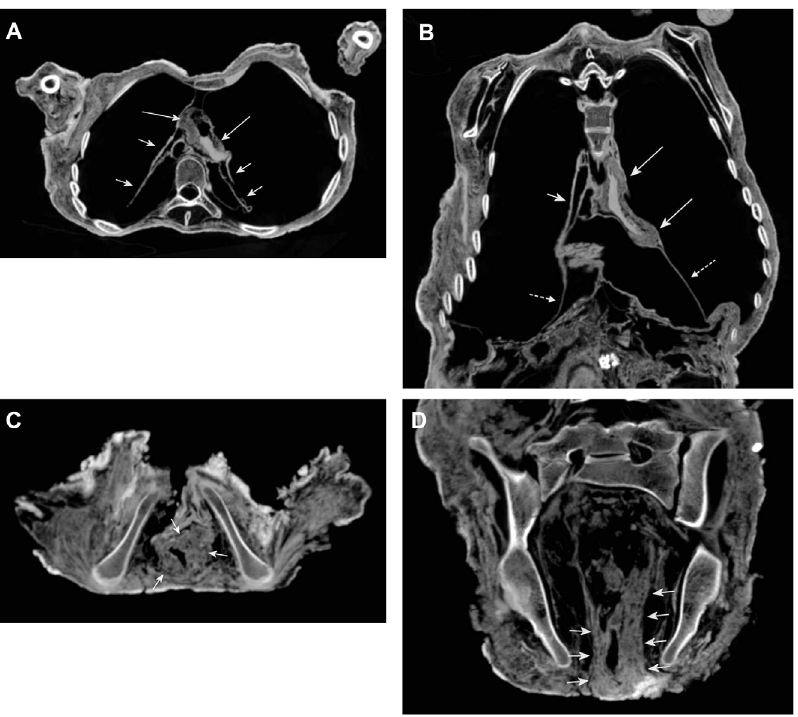
Figure 5. Paleoradiology – Pathologically thickened wall of the heart and rectum. ( A ) Axial and ( B ) coronar CT reformation image of the chest illustrating collapsed lung (short arrows) and a relatively large heart with a markedly thickened wall (long arrows). The heart overlies the diaphragm (dotted arrow in B). The longish hyperdense structure inside the heart represents dried blood. ( C ) Axial and ( D ) coronar CT reformation image of the lesser pelvis demonstrating massive circular thickening of the wall of the rectum (arrows). Centrally, the inflated lumen is discernible. The combination of pathologically thickened wall of the heart and rectum suggested the diagnosis of Chagas disease. For further investigations, minimal destructive biopsy of the rectum was planned on the basis of the CT reformation images. doi:10.1371/journal.pone.0089528.g005 Head. The three-dimensional reconstructions of the head revealed an Inca bone (Figure 3) representing an additional bone in the lambdoid suture which can be classified as type III according to the Hanihara and Ishida classification [16].